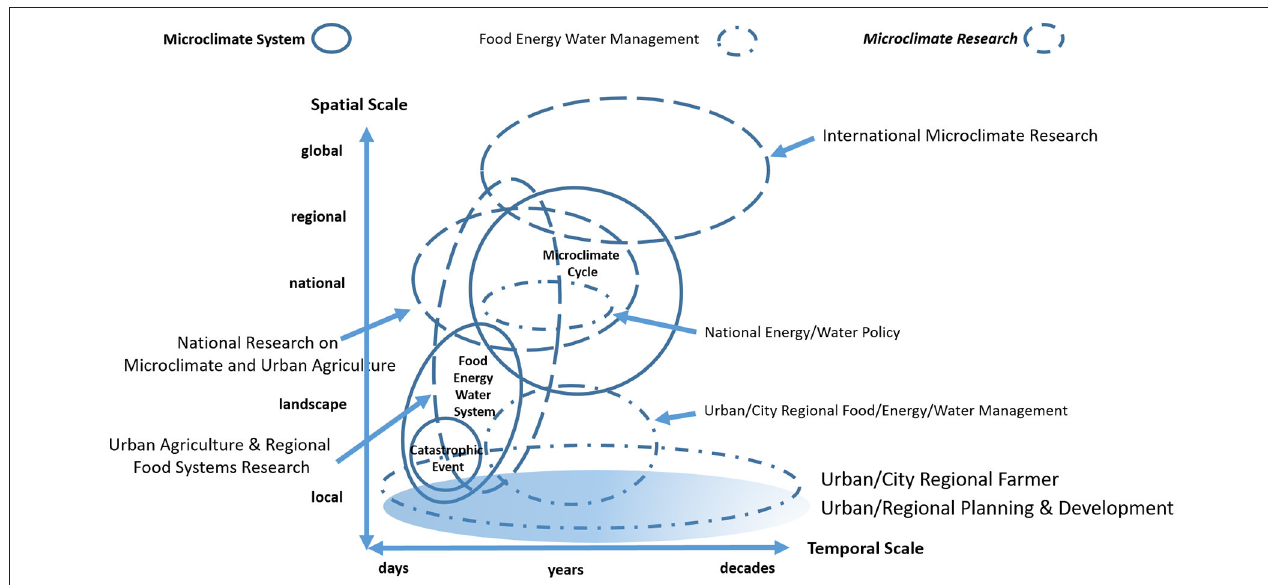
FIGURE 7 | Schematic example of urbanizing food-energy-water nexus factors and trends across spatial, organizational, and temporal scales and levels. This schematic diagram can be used to illustrate the spatial and temporal dimensions of socio ecological phenomena (the microclimate-related system represented as a solid line) and the interaction of two human domains: microclimate research (hashed line) and regional energy/water management (hash-dotted lines). These figures are adapted from Cash et al.